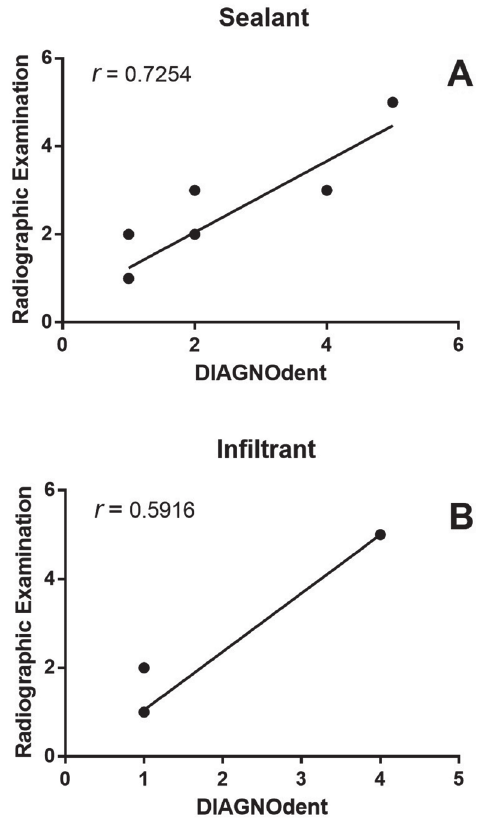
Figure 1- Correlation between the DIAGNOdent method and radiographic analysis for varying sealant material